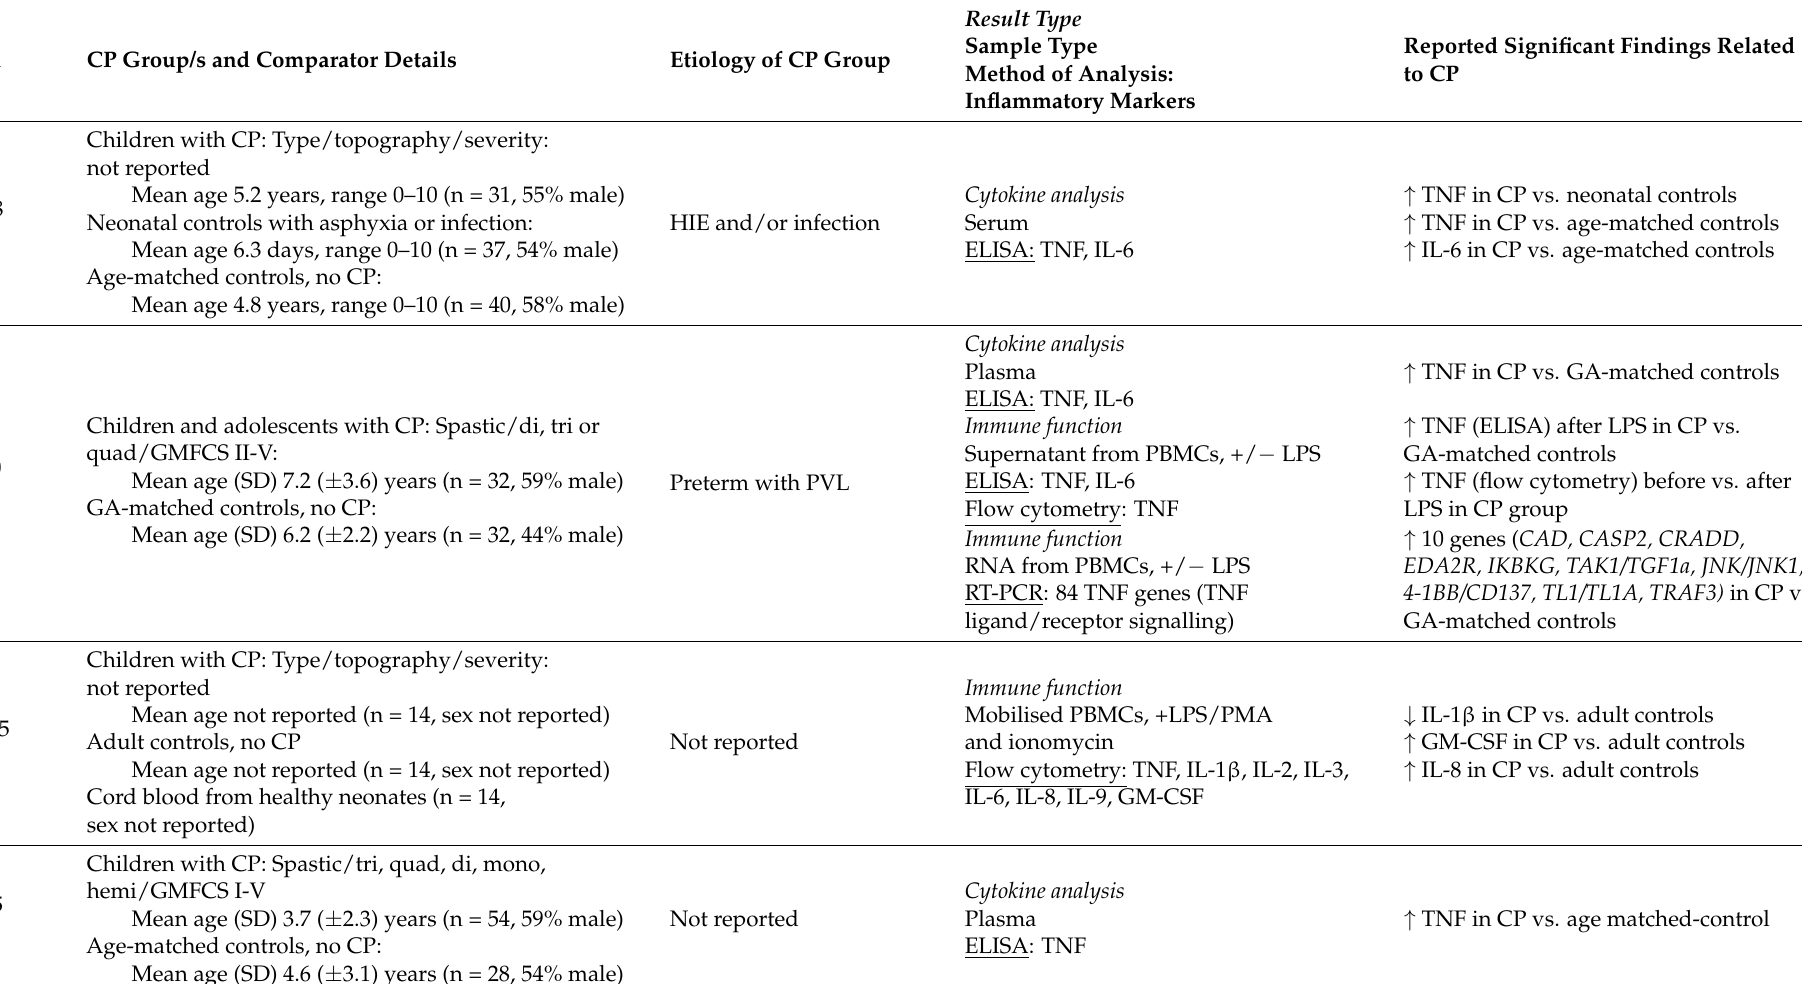
Table 1. Study characteristics and main